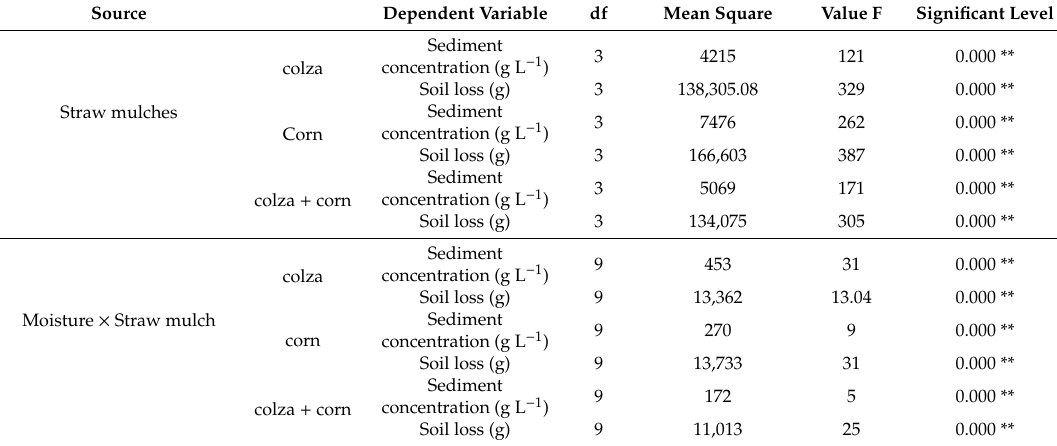
Table 2. General linear model test after applying the one way and two-way ANOVAs per soil moisture condition and straw mulch application, considering soil loss and sediment concentration.